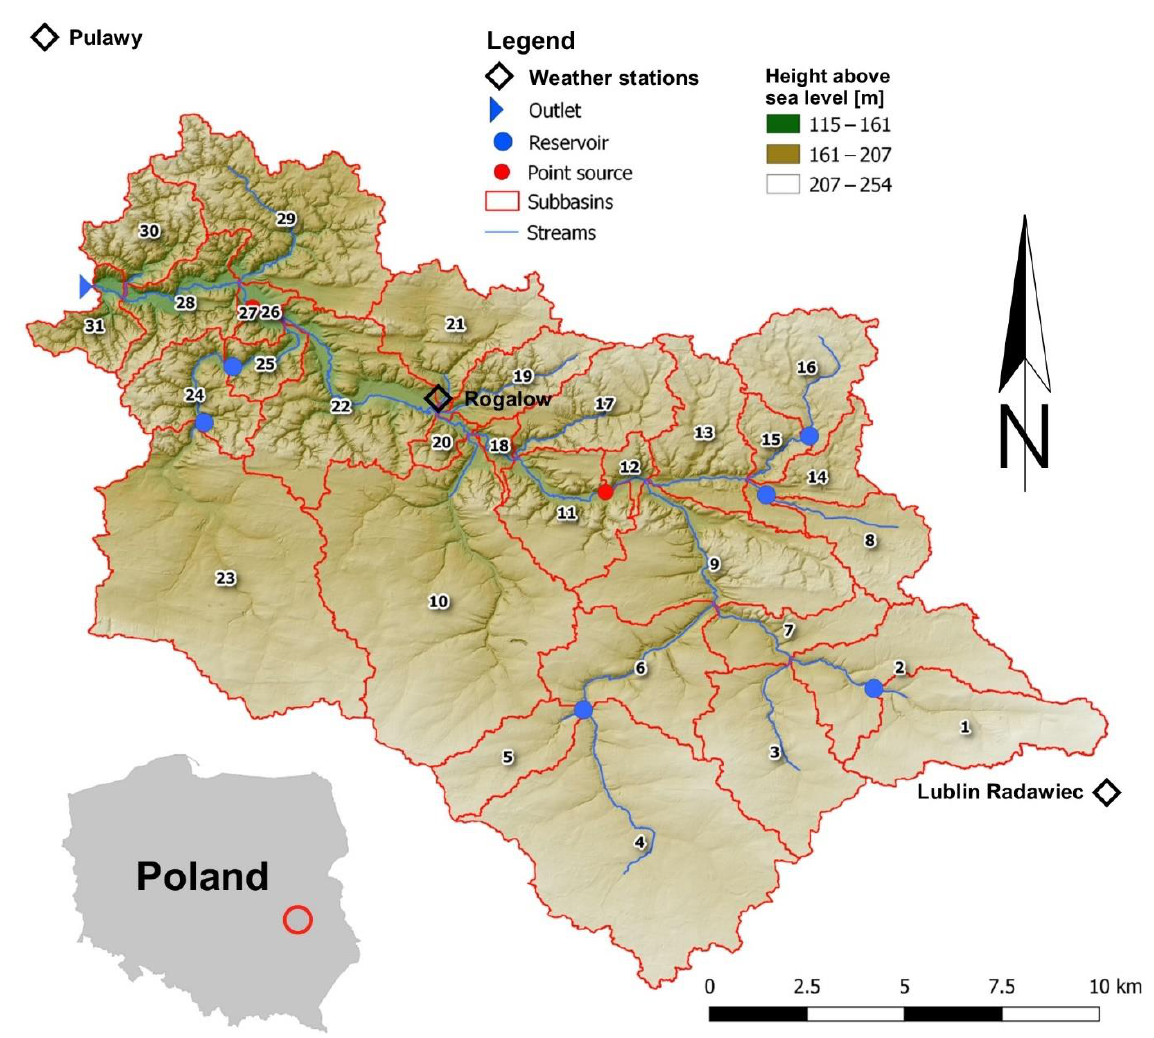
Figure 1. Location of the study area, Bystra catchment, with marked main tributaries and their catchments (own study).